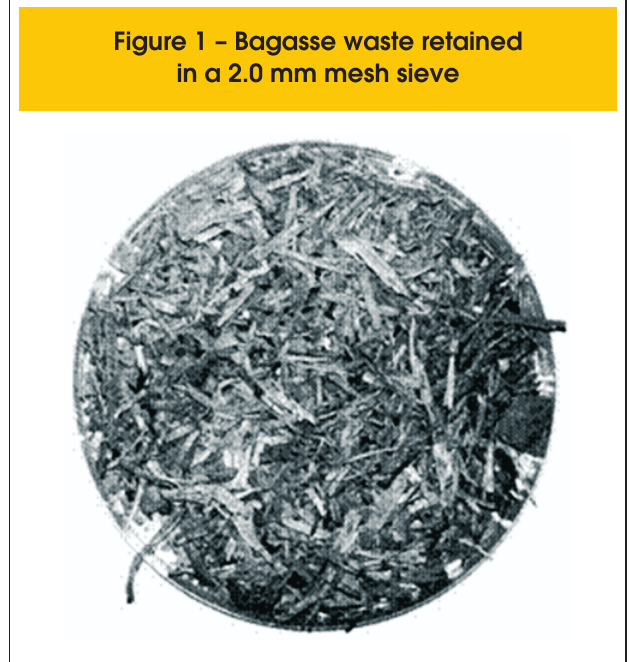
Figure 4 – (a) PET bottle mold (b) Concreting supportFigure 1 – Bagasse waste of the PET bottle mold on the metal